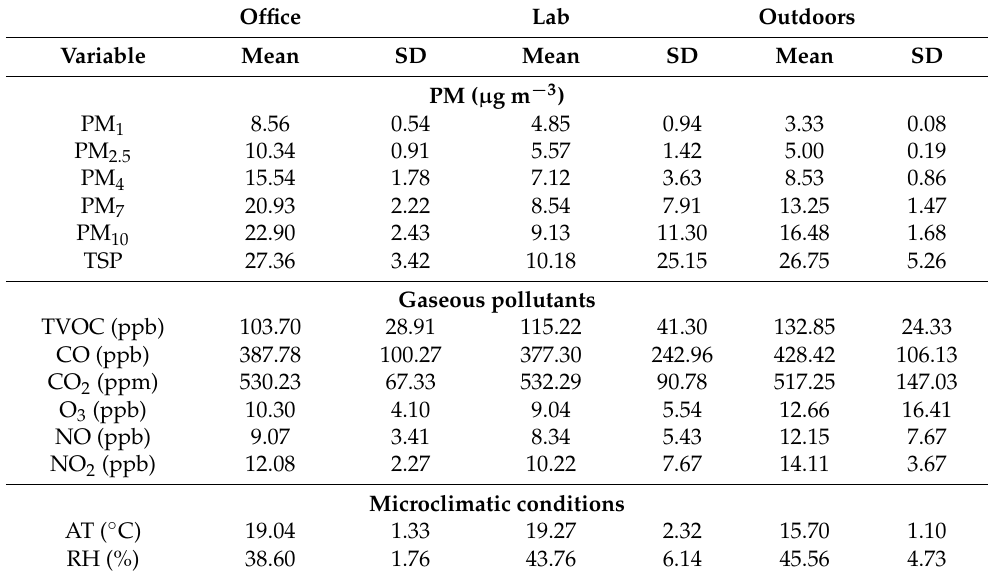
Table 2. Descriptive statistics of indoor and outdoor atmospheric pollutant concentrations along with air temperature and RH (Campaign 1).